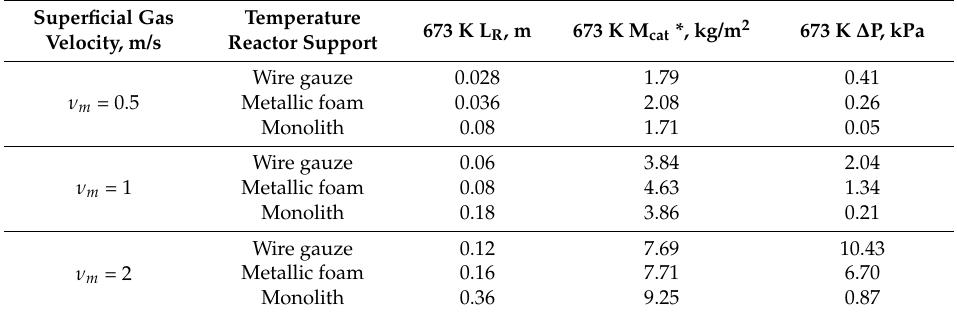
Table 2. Reactor performance for an arbitrary assumed final conversion of X = 0.9 of 2500 ppm NO at 673 K and gas velocities Cu/USY/s catalyst.